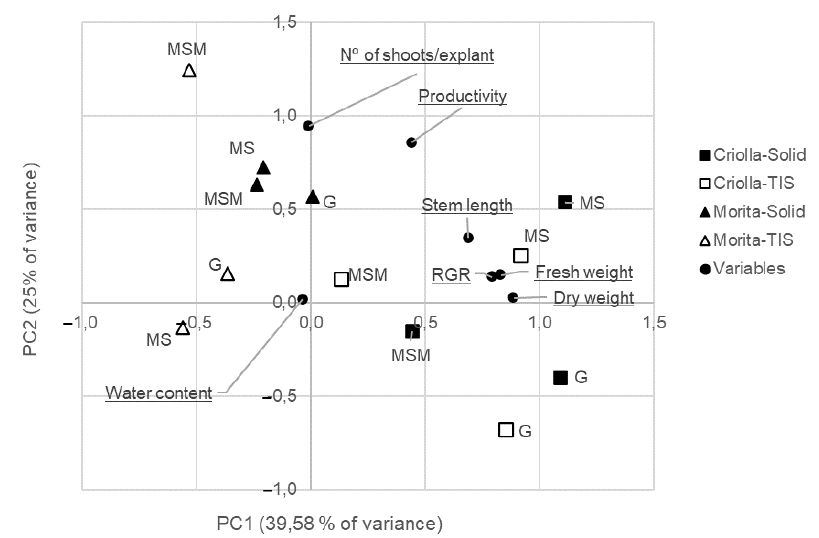
Figure 2. Principal component analysis mean scores plot for each combined treatment (black squares: Criolla with solid system; white squares: Criolla with TIS; black triangles: Morita with solid system; white triangle: Morita with TIS. black circle. The variables are underlined and (Table 3) are in bold. MS, MSM, and G are the culture media. Table 3. Correlation coefficients between each variable and the three factors resulting from Varimax- rotated principal component analysis, eigenvalues, and percentage variance accounted for.